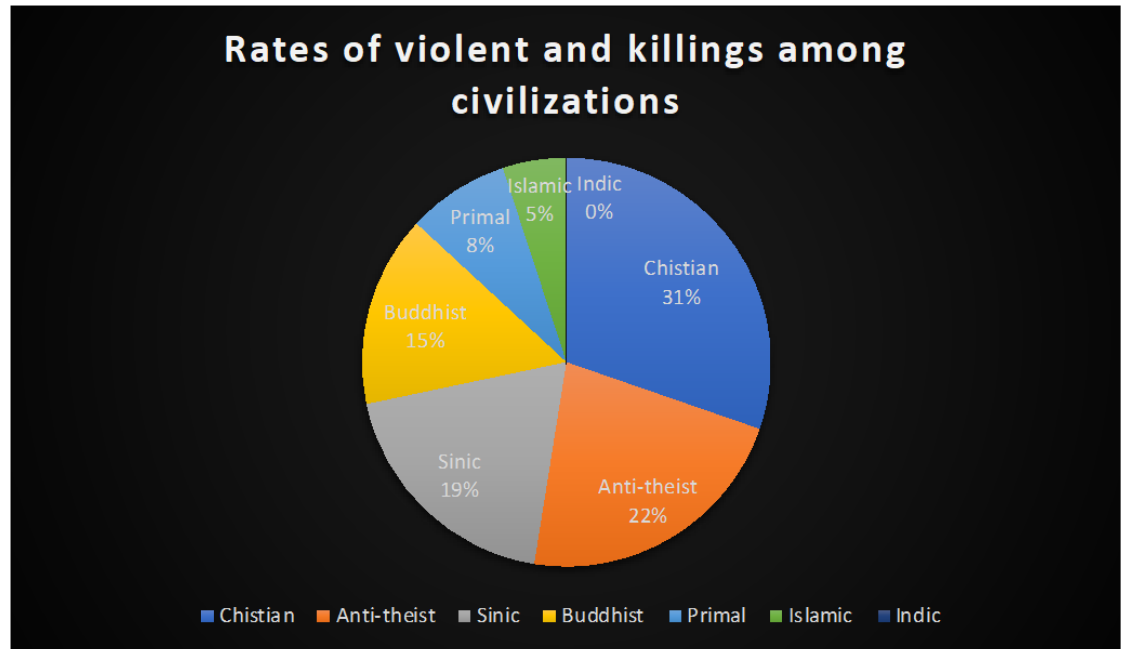
Figure 3. Rates of violence and killings among civilizations.